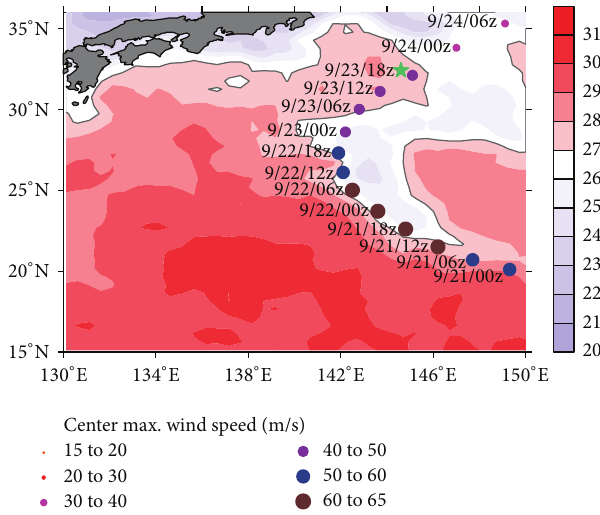
Figure 1: Daily averaged sea surface temperature (SST) (color fill, in ∘ C) derived from the Reynolds SST dataset on September 23. Green pentacle represents the location of the Kuroshio Extension Observatory(KEO)mooring.Colordotsindicatethecenterlocation of Yagi on September 21–24 (every 6h). Thin black curves indicate the 27 ∘ C